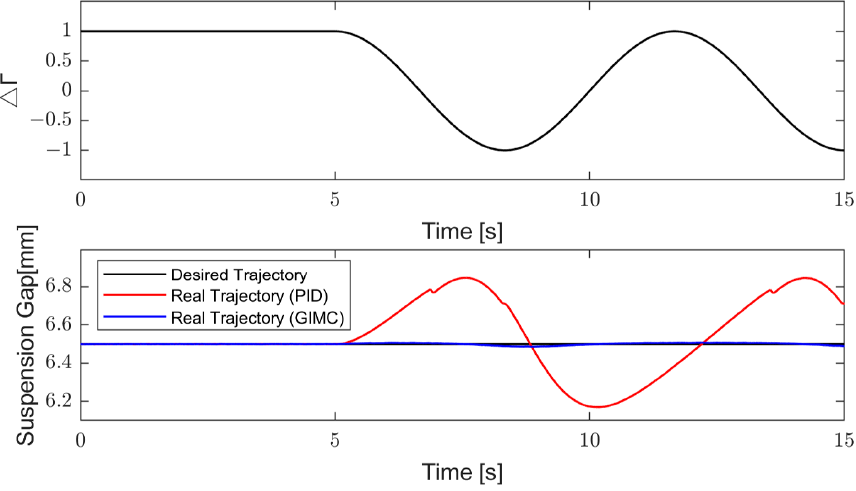
Figure 16. The result of simulation